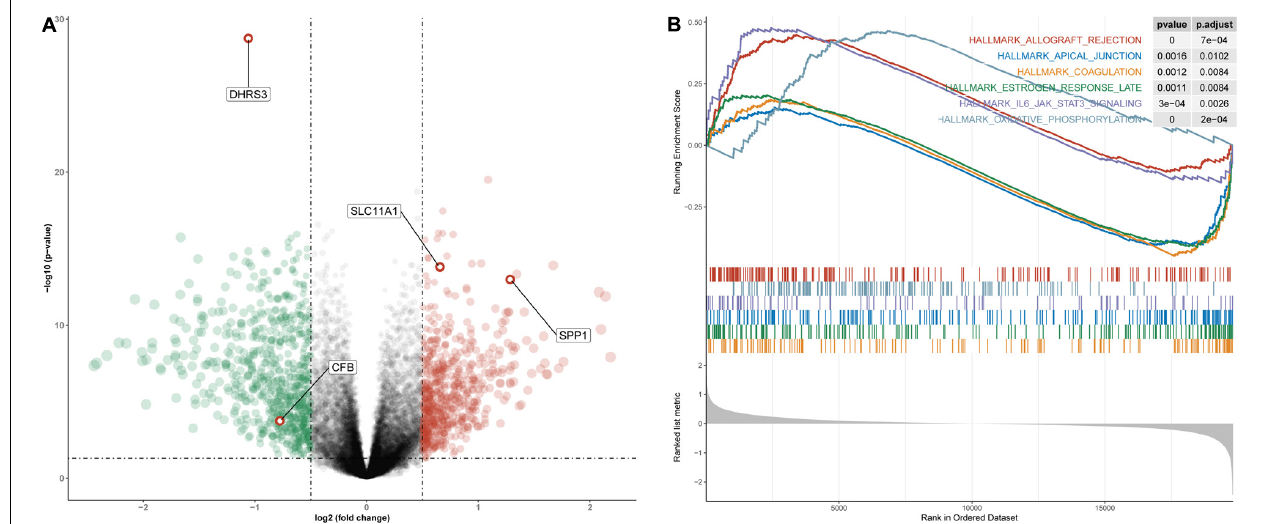
FIGURE 10 | Differential gene expression analysis and GSEA for high- and low-risk groups in the entire cohort. (A) Volcano plot for differentially expressed genes. Red dots represent genes whose expression is upregulated, green dots represent genes whose expression is downregulated, and red circles represent hub genes. (B) The three pathways with the smallest NES and the three pathways with the largest NES are